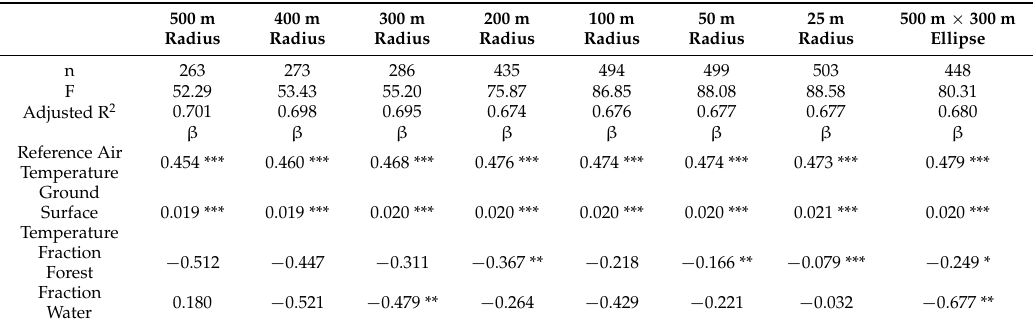
Table 6. Comparison of radii used for air temperature OLS regression